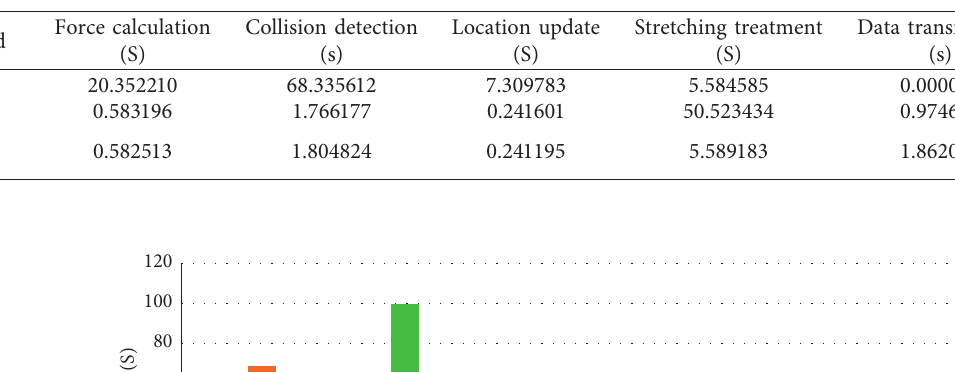
Figure 6: Analysis of the research data of fabric No. Table 7: Simulation time statistics.